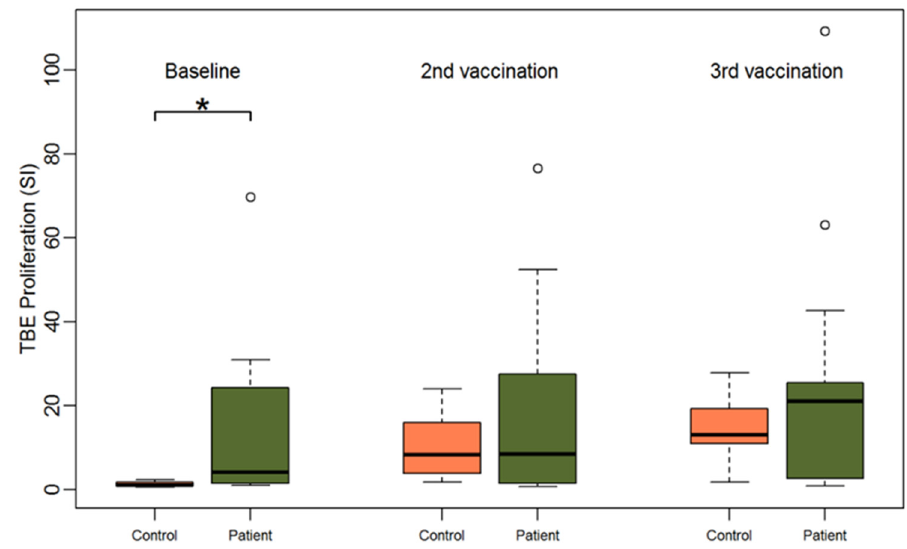
Figure 1. Boxplots showing the median and distribution of lymphocyte proliferation as detected by thymidine incorporation assay (the stimulation indices are given) at three different time points for healthy controls (orange) and patients (green) after stimulation with TBE antigen. Asterisk marks significant p -value ( p =